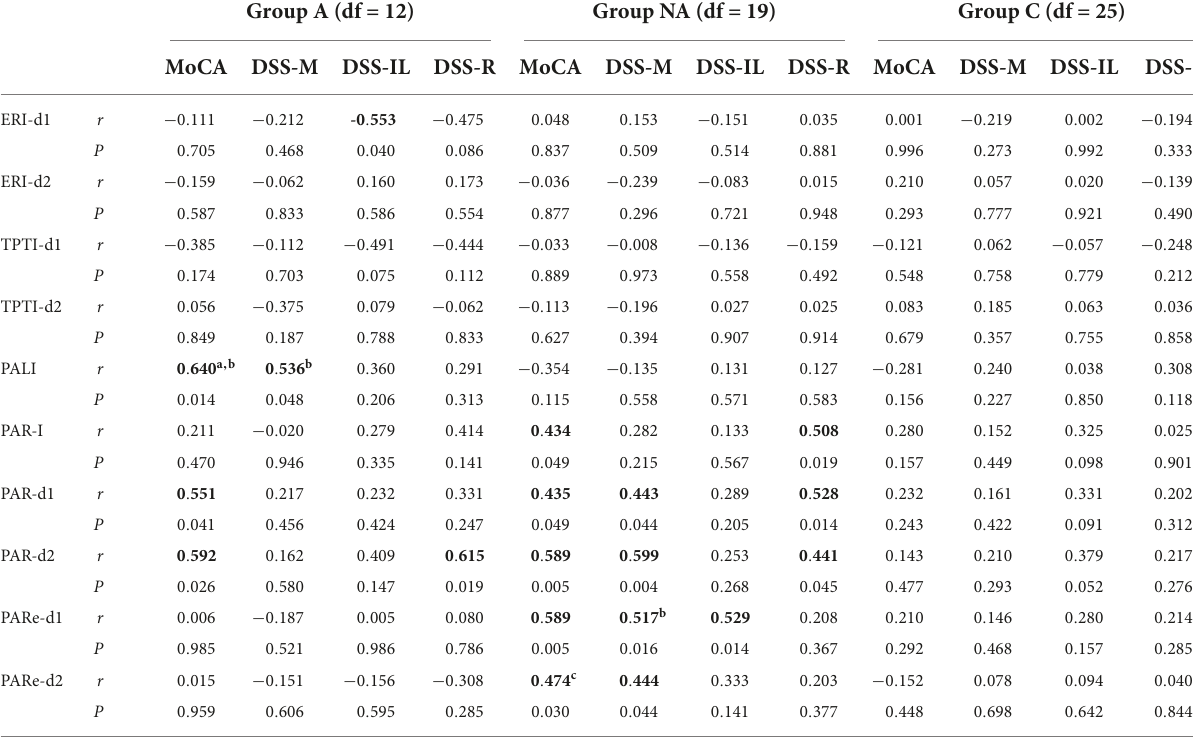
TABLE 3 Non-parametric partial correlations controlling for sex and